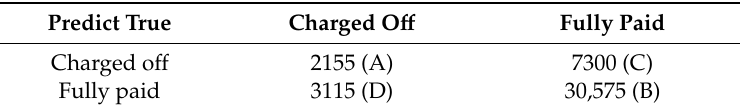
Table 8. Confusion